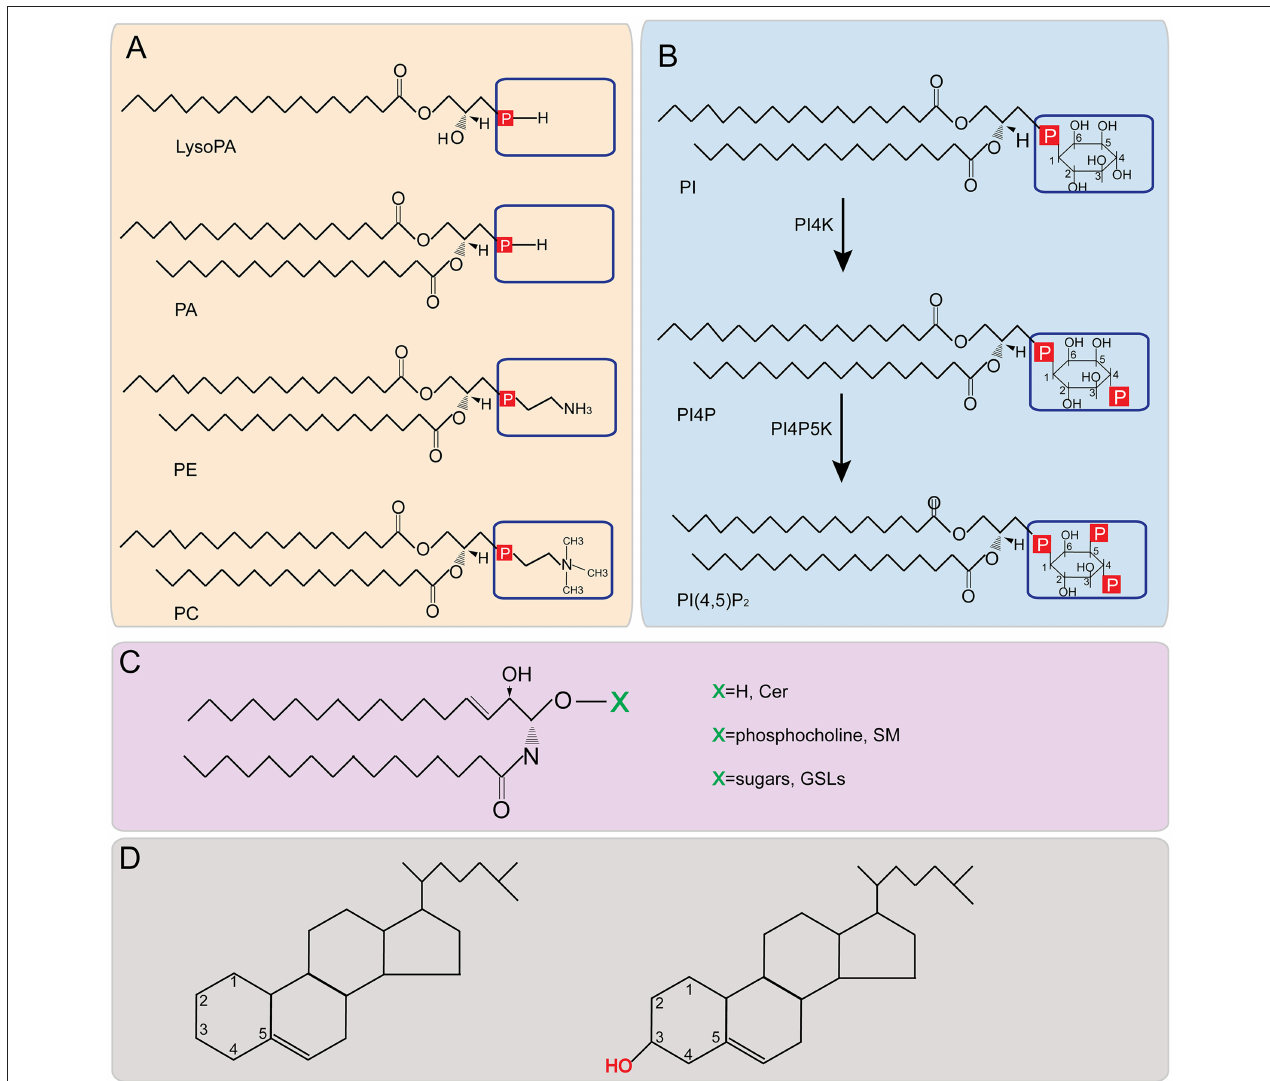
FIGURE 1 | Structures of major lipids. (A,B) Phospholipid structure representations. Boxed areas indicate the different headgroups among various phospholipids. (C) Structure of sphingolipids. X represents different headgroups of different sphingolipids. (D) Basic structure of sterol (Left) and the structure of cholesterol (Right). PA, phosphatidic acid; PE, phosphatidylethanolamine; PC, phosphatidylcholine; PI, phosphatidylinositol; PI4P, phosphatidylinositol-4-phosphate; PI(4,5)P 2 , phosphatidylinositol-4,5-bisphosphate; PI4K, Phosphatidylinositol-4 kinase; PI4P5K, phosphatidylinositol 4-phosphate 5-kinase; Cer, ceramide; SM, sphingomyelin; GSL,